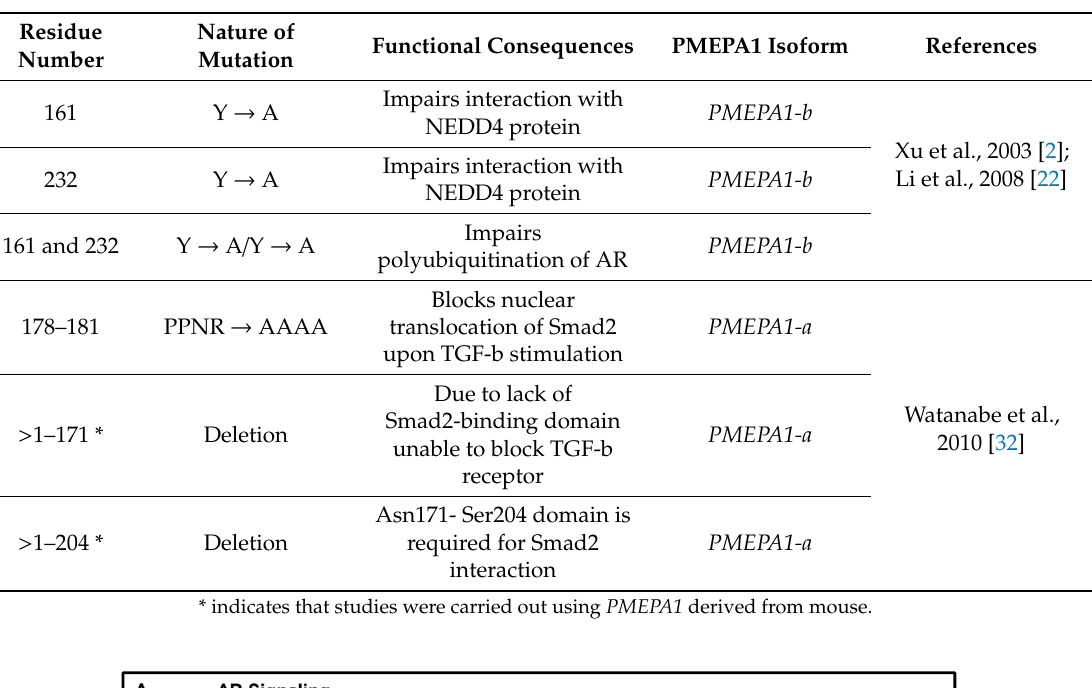
Table 5. Analysis of PMEPA1